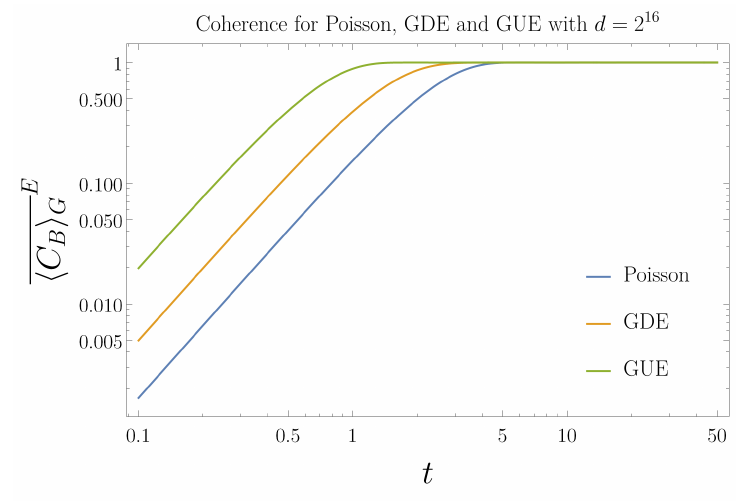
( ψ ) 〉 , with ψ = Π for GUE, Poisson , GDE and B U j G